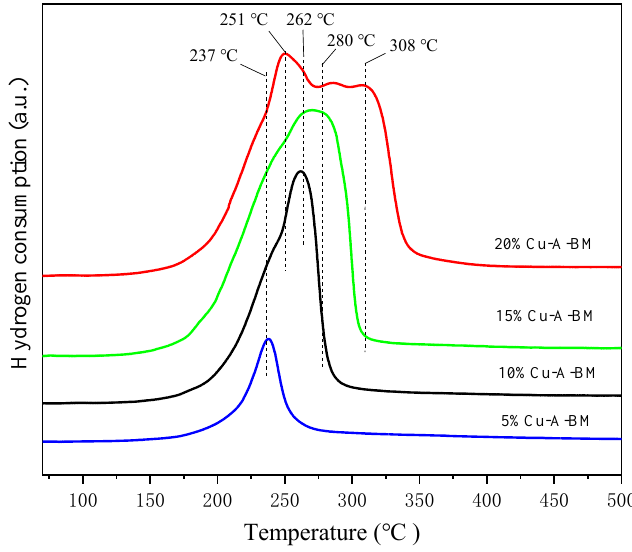
Figure 7. TPR profiles of W% Cu-A-BM catalysts.